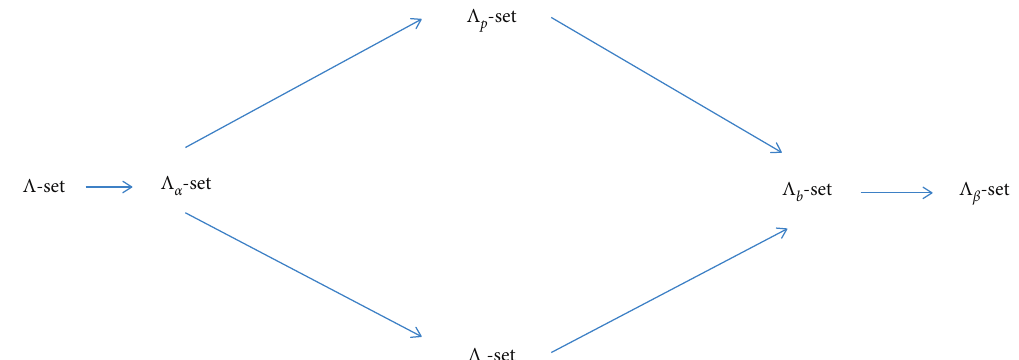
Figure 1: Relationship between some forms of near Λ